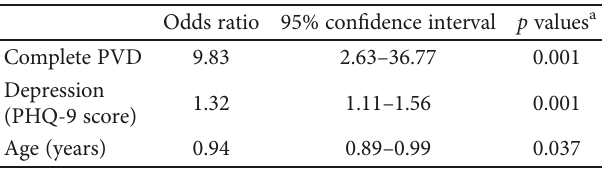
Table 2: Multivariate analysis on factors associated with symptomatic fl oaters.